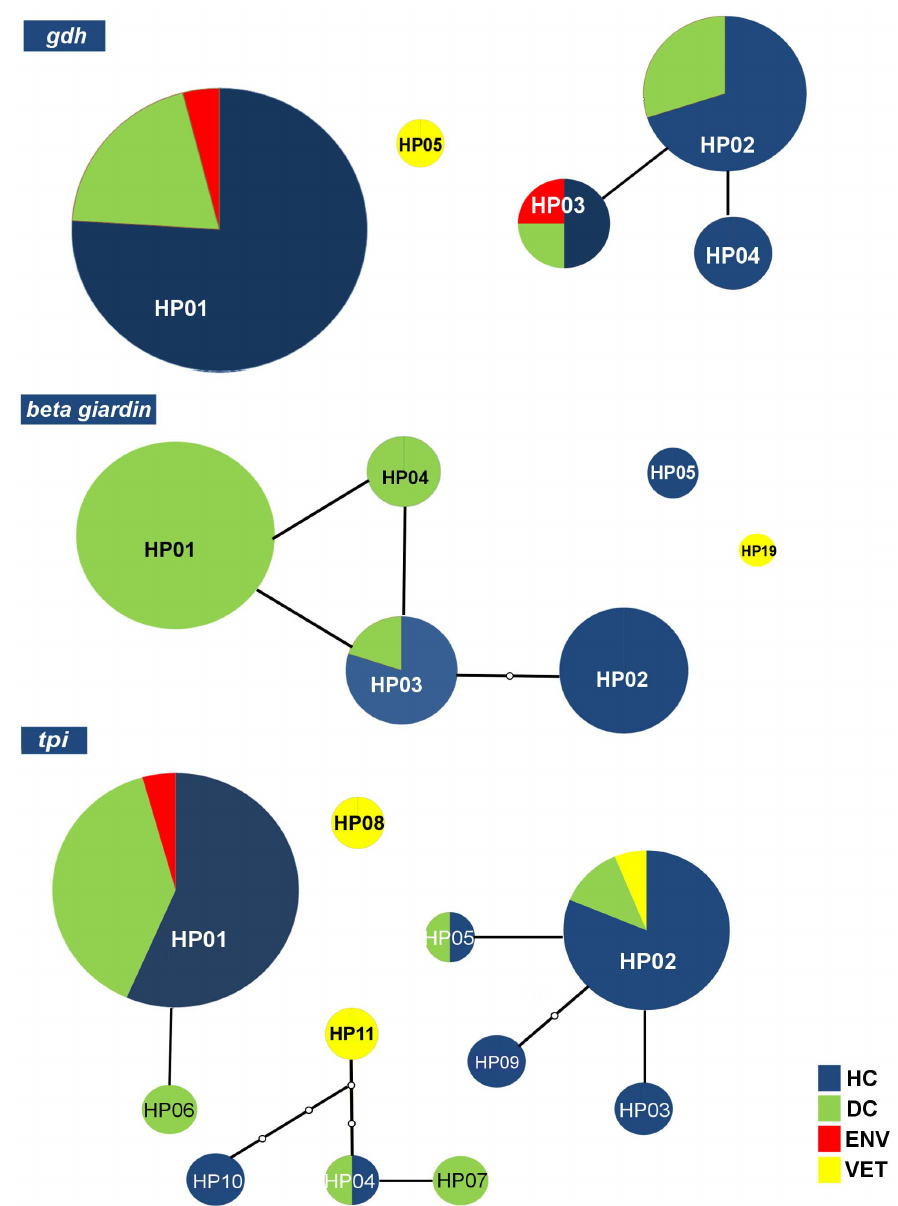
Fig. 2. Networks of G. duodenalis haplotypes within the gdh, bg, and tpi genes. The relative frequencies of the main haplotypes from the day-care center (green), hospital clinical (dark blue), veterinary (yellow) and environmental (red) samples generated from a statistical parsimony network. The sizes of the circles are proportional to the haplotype frequency. The lines connecting each haplotype represent one mutation, and small white circles represent inferred haplotypes that were not actually observed. Haplotypes that are not connected to others exhibited more steps (or mutations) than the connection limit (95% confidence).